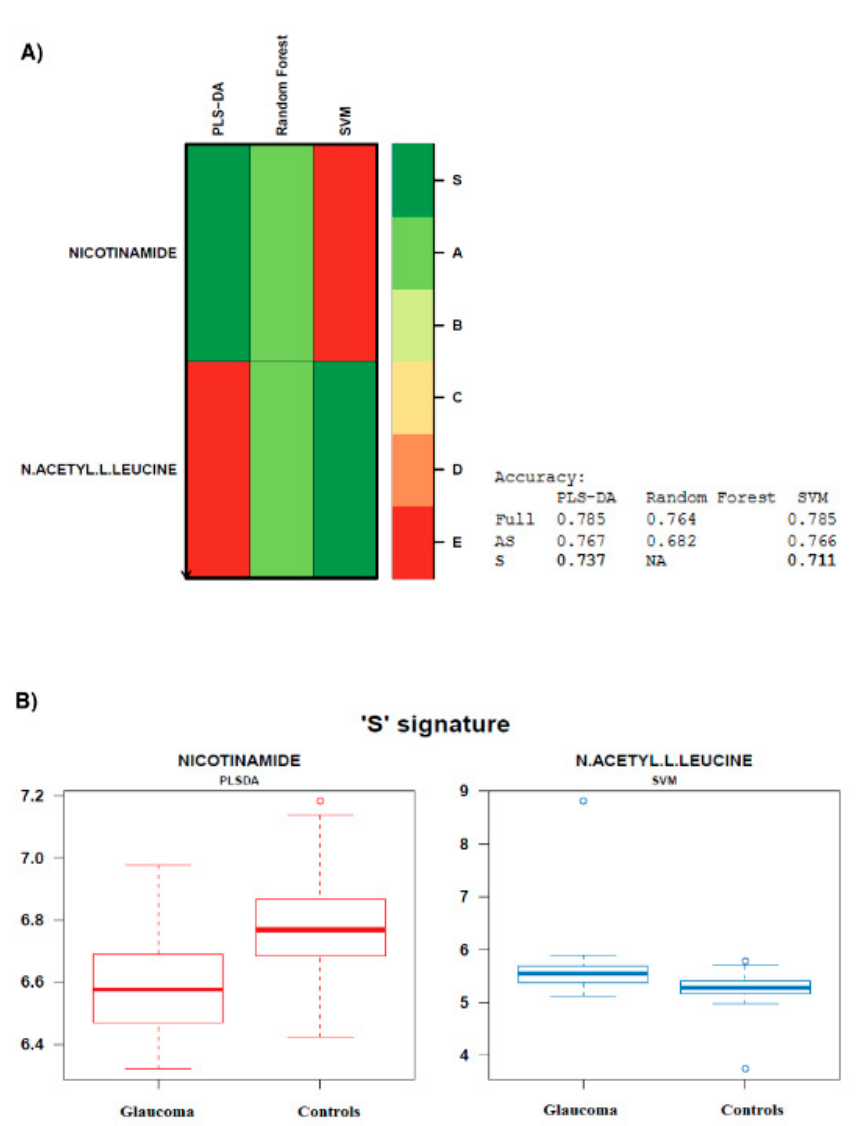
Figure 3. Biosigner signature. ( A ) The algorithm assessed the relevance of the 160 metabolites identified for the prediction performances of Partial Least Squares-Discriminant Analysis (PLS-DA), Random Forest (RF), and Support Vector Machines (SVM) classifier models and subsequently identified 2 robust ‘S tier’ features, i.e., nicotinamide and N-acetyl L-leucine. The accuracies of the PLS-DA and SVM models on the final S signature were respectively 73.7% and 71.1% for nicotinamide and N-acetyl L-leucine. ( B ) The boxplots depict the metabolite levels in glaucoma and control groups. Error bars represent ± s.e.m and the solid bars within the boxplots represent the median level of metabolite (log transformed peak area) for each